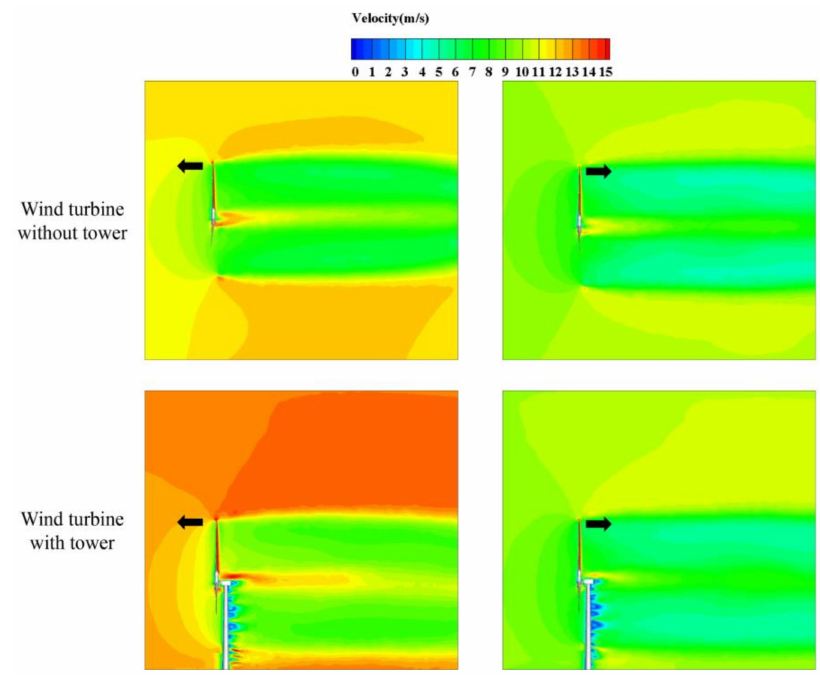
Figure 12. Velocity contours of wake field under surge